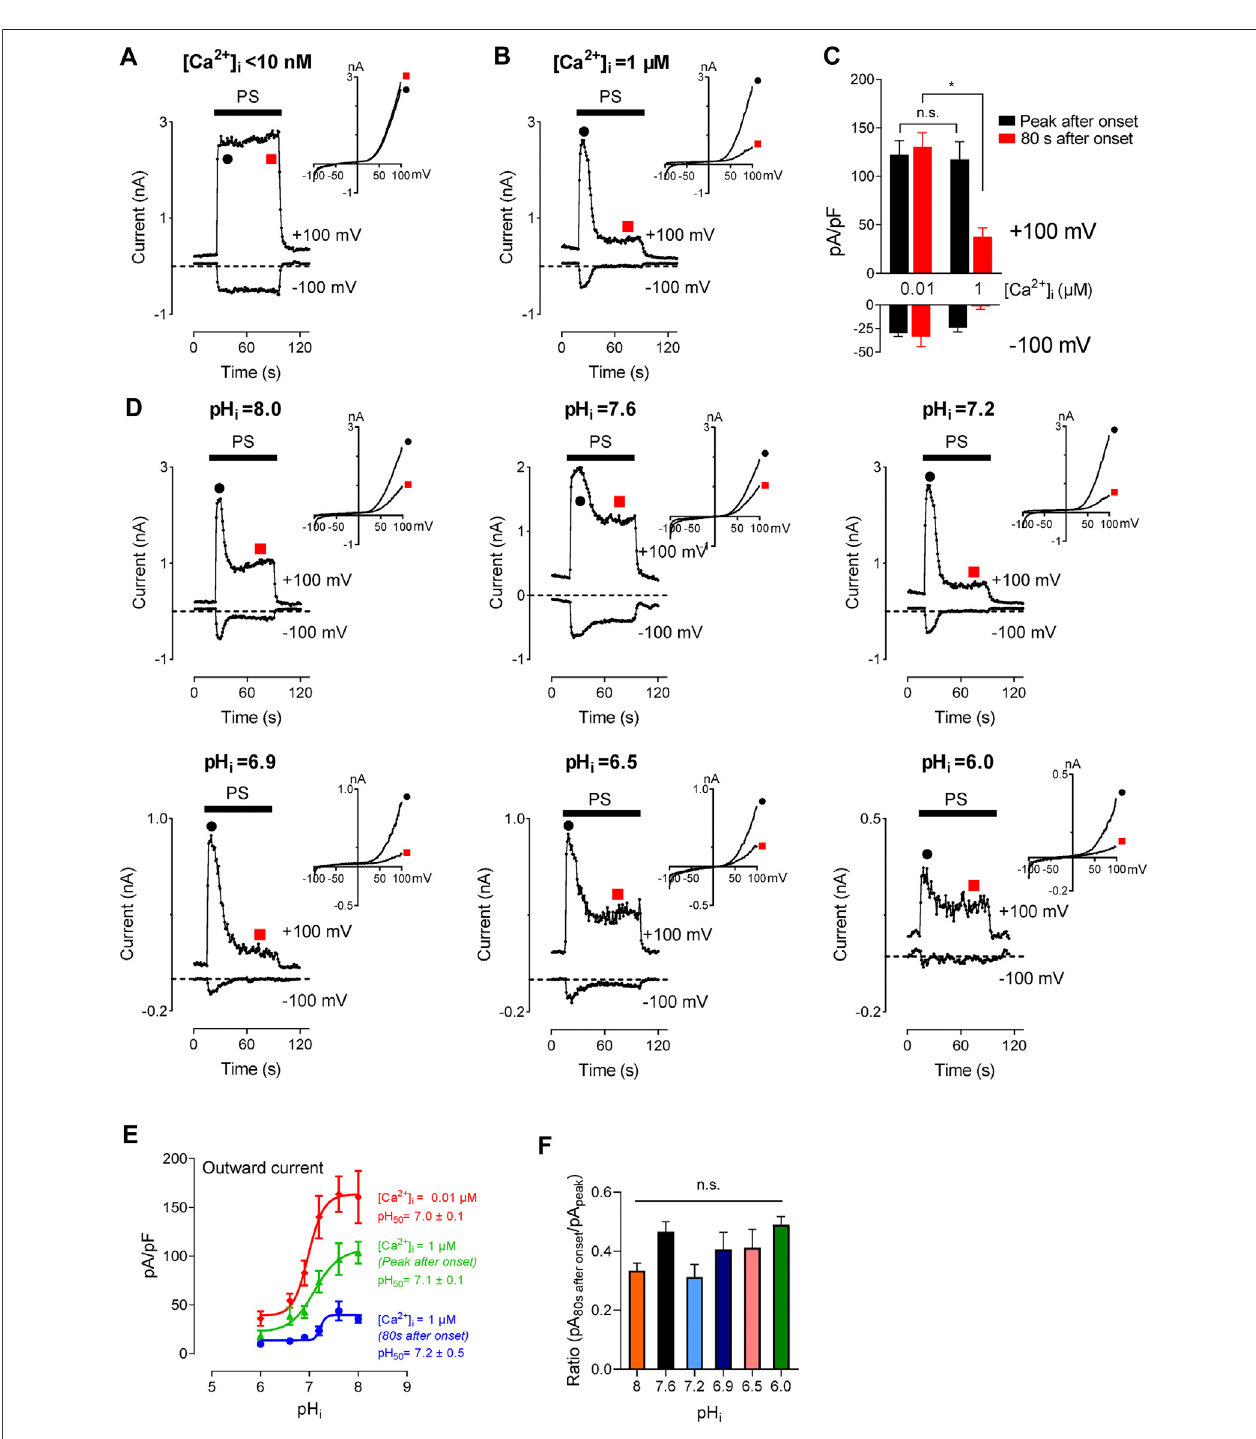
FIGURE 6 | Inhibitory effect of intracellular high Ca 2+ on TRPM3 activation by PS. (A,B) Time course of TRPM3 currents elicited by voltage ramps ranging − 100 to +100 mV at the indicated [Ca 2+ ] i concentration. At high [Ca 2+ ] i (1 µM), TRPM3 is activated by PS initially (Black symbol) but runs down soon afterward (Red symbol). WhereastheTRPM3currentwassustainedatthelow[Ca 2+ ] i condition.Insertsshowtherepresentativerecordingsfromtheindicatedpoints. (C) Meancurrentamplitude ofTRPM3attheindicated[Ca 2+ ] i (mean ± SEM; n (cid:2) 10).*indicates p < 0.05byunpairedStudent ’ st-test; “ n.s. ” indicatesnotstatisticallysigni fi cant. (D) Timecourse and representative recordings of TRPM3 current with [Ca 2+ ] i (1 µM) at the indicated pH i from pH i 8.0 to pH i 6.0. (E) pH concentration-dependence of TRPM3 activation by PS at the indicated [Ca 2+ ] i . Green and blue symbols both represent high [Ca 2+ ] i , while green represents currents elicited right after PS application (peak after onset), and blue represent currents remaining after inhibition of by high [Ca 2+ ] i (80 s after onset). All currents were normalized to the corresponding capacitance of the cell